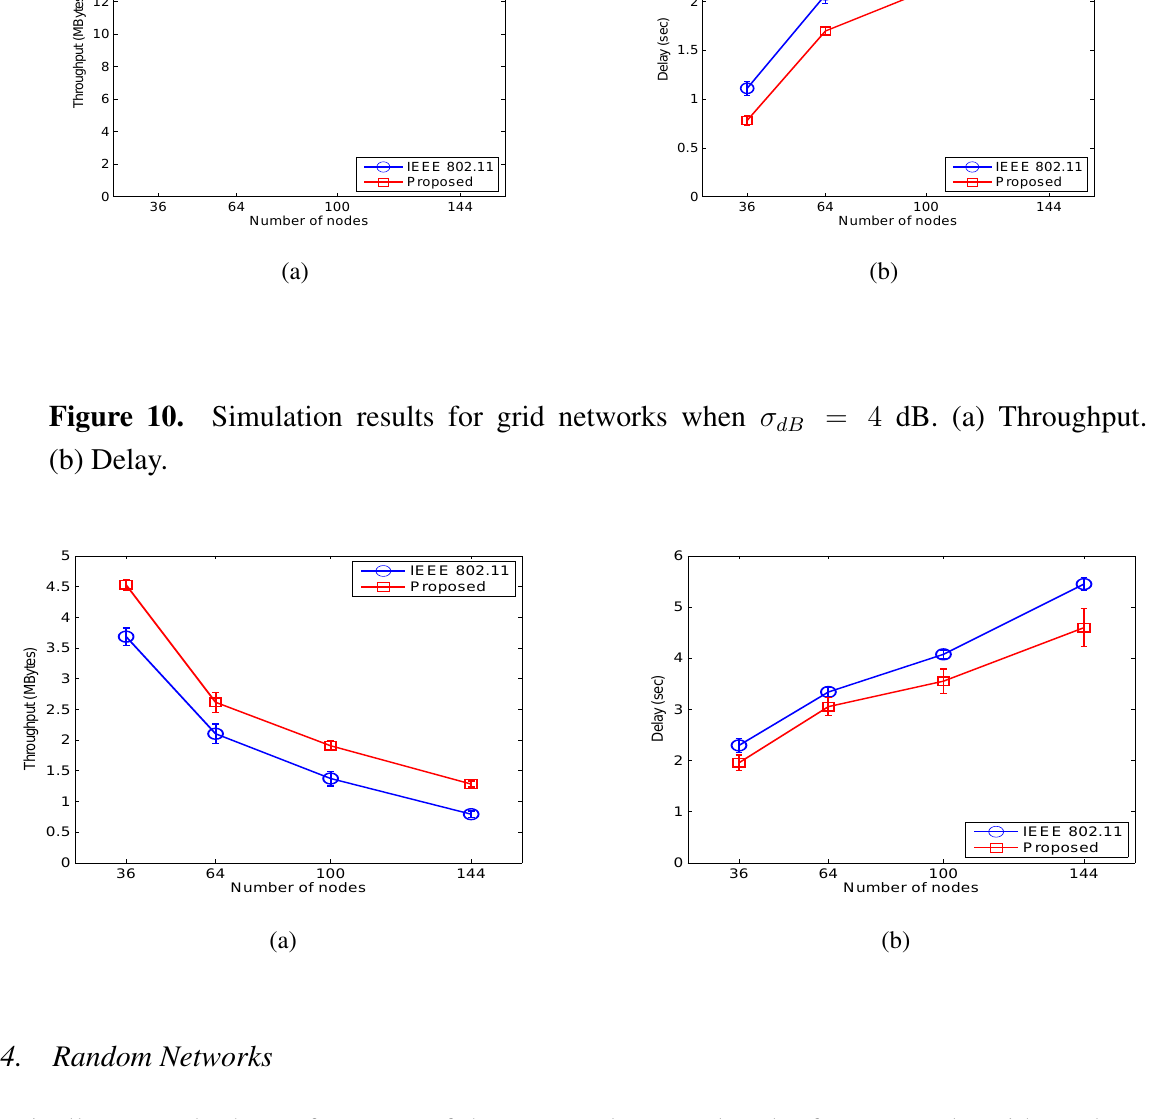
Figure 9. Simulation results for grid networks when σ (b) Delay.